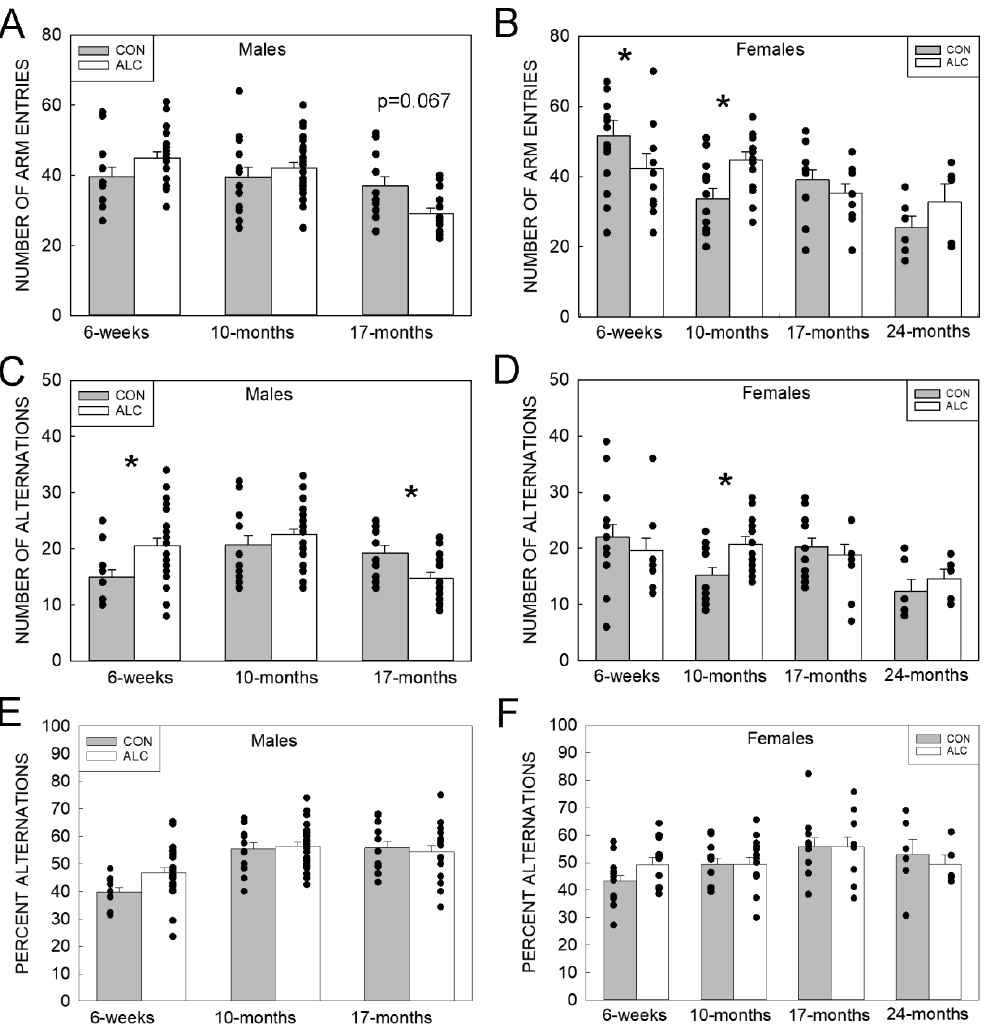
Figure 4. ALC and CON performance on the Y-maze task. ( A , B ) Number of arm entries does not differ in males ( A ), and differs in ALC and CON females at 6 weeks and 10 months. ( C , D ) The number of arm alternations differs in ALC and CON males at 6 weeks and 17-mo ( C ), and differs in ALC and CON females at 10 months ( D ). ( E , F ) The percentage of alternations did not differ by exposure in males ( E ) and females ( F ) at all ages tested. Values are mean ± SEM, dots represent values for individual animals. The number of animals tested in each group is presented in Supplemental Table S1. * Indi- cates ALC differs from CON at p ≤ 0.05.